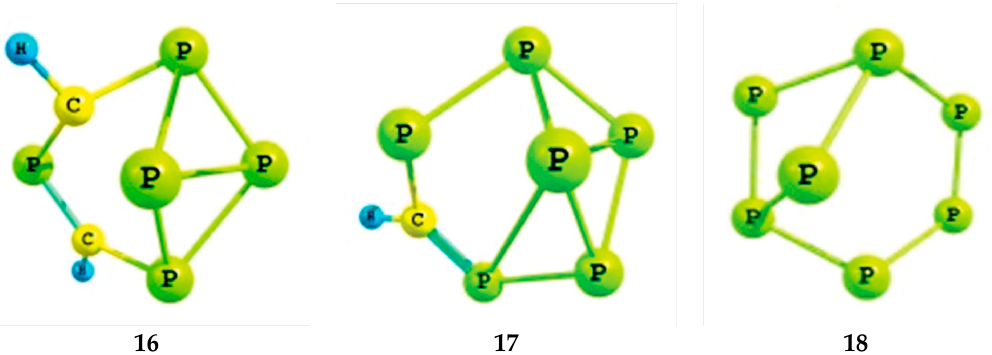
Figure 2. 5P ( 16 ), 6P ( 17 ) and 7P ( 18 ) analogues of tropylium ion.